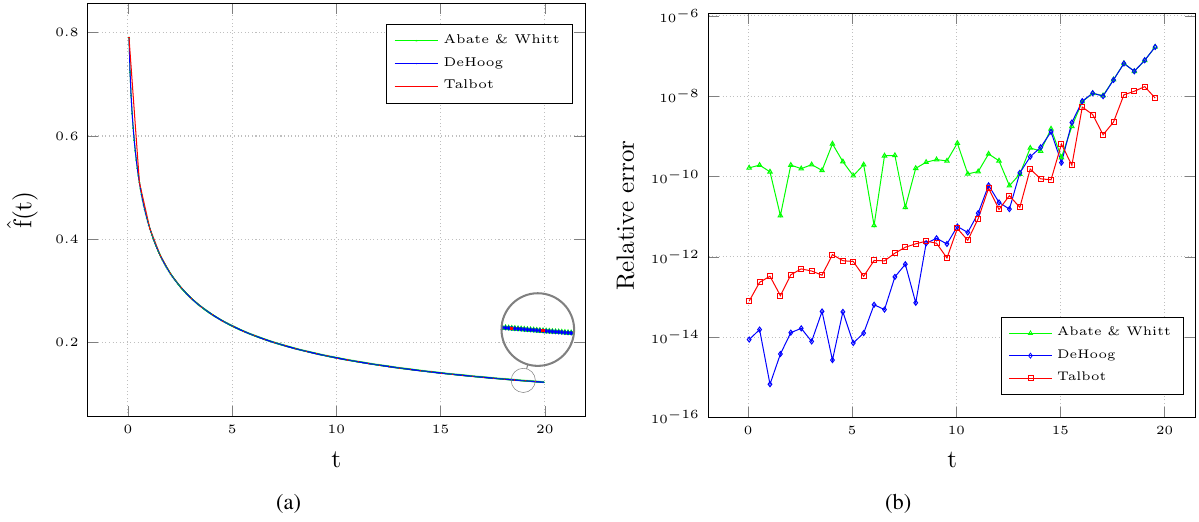
Fig. 7 Plots of numerical inversions ˆ f ( t ) of the Laplace transform (7) (a) and their relative errors (b) for applied methods in interval ( 0 , 30 (cid:105) .